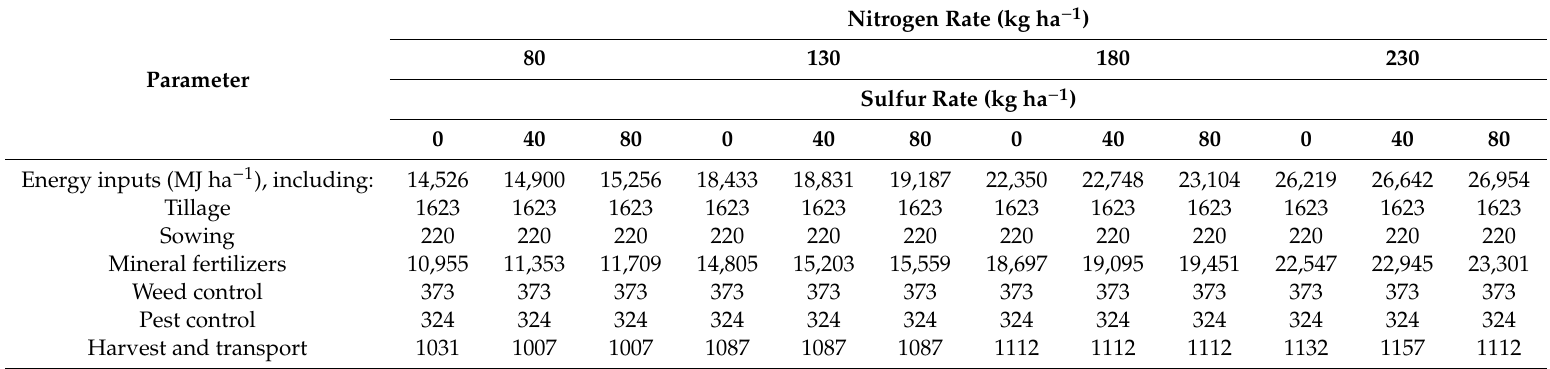
Table 13. Energy inputs in the production of semi-dwarf hybrid cultivar of winter oilseed rape (cv. PR44 D06), across years.